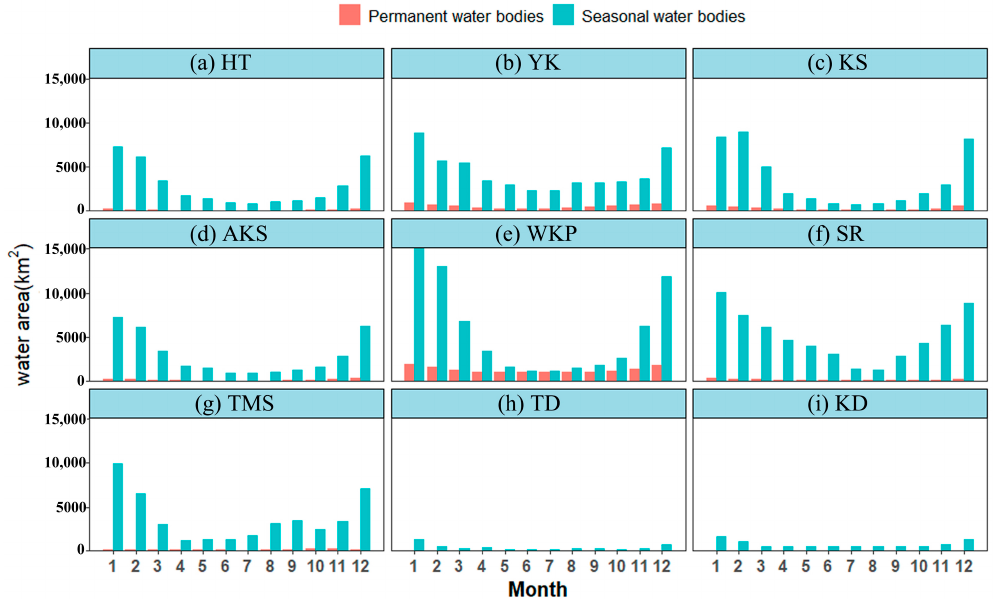
Figure 8. The monthly variation of surface water bodies for 1984 to 2019 in the ( a ) HT; ( b )YK; ( c ) KS; ( d ) AKS; ( e ) WKP; ( f ) SR; ( g ) TMS; ( h ) TD; and ( i ) KD. HT, Hotan River Basin; YK, the Yarkant River Basin; KS, Kashgar River Basin; AKS, Aksu River Basin; WKP, Weikan-Kaidu-Peacock River Basin; SR, Rivers in Southern Xinjiang; TMS, the Tarim Main Stream; TD, Taklamakan Desert; and KD, Kumtag